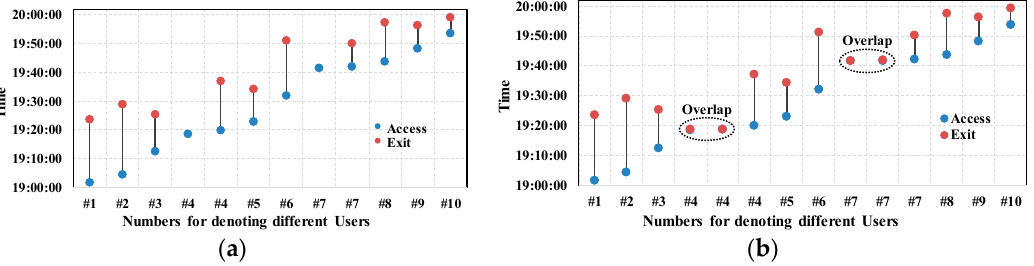
Figure 8. Experimental results: ( a ) Records of the experiment; ( b ) Output information of the system.